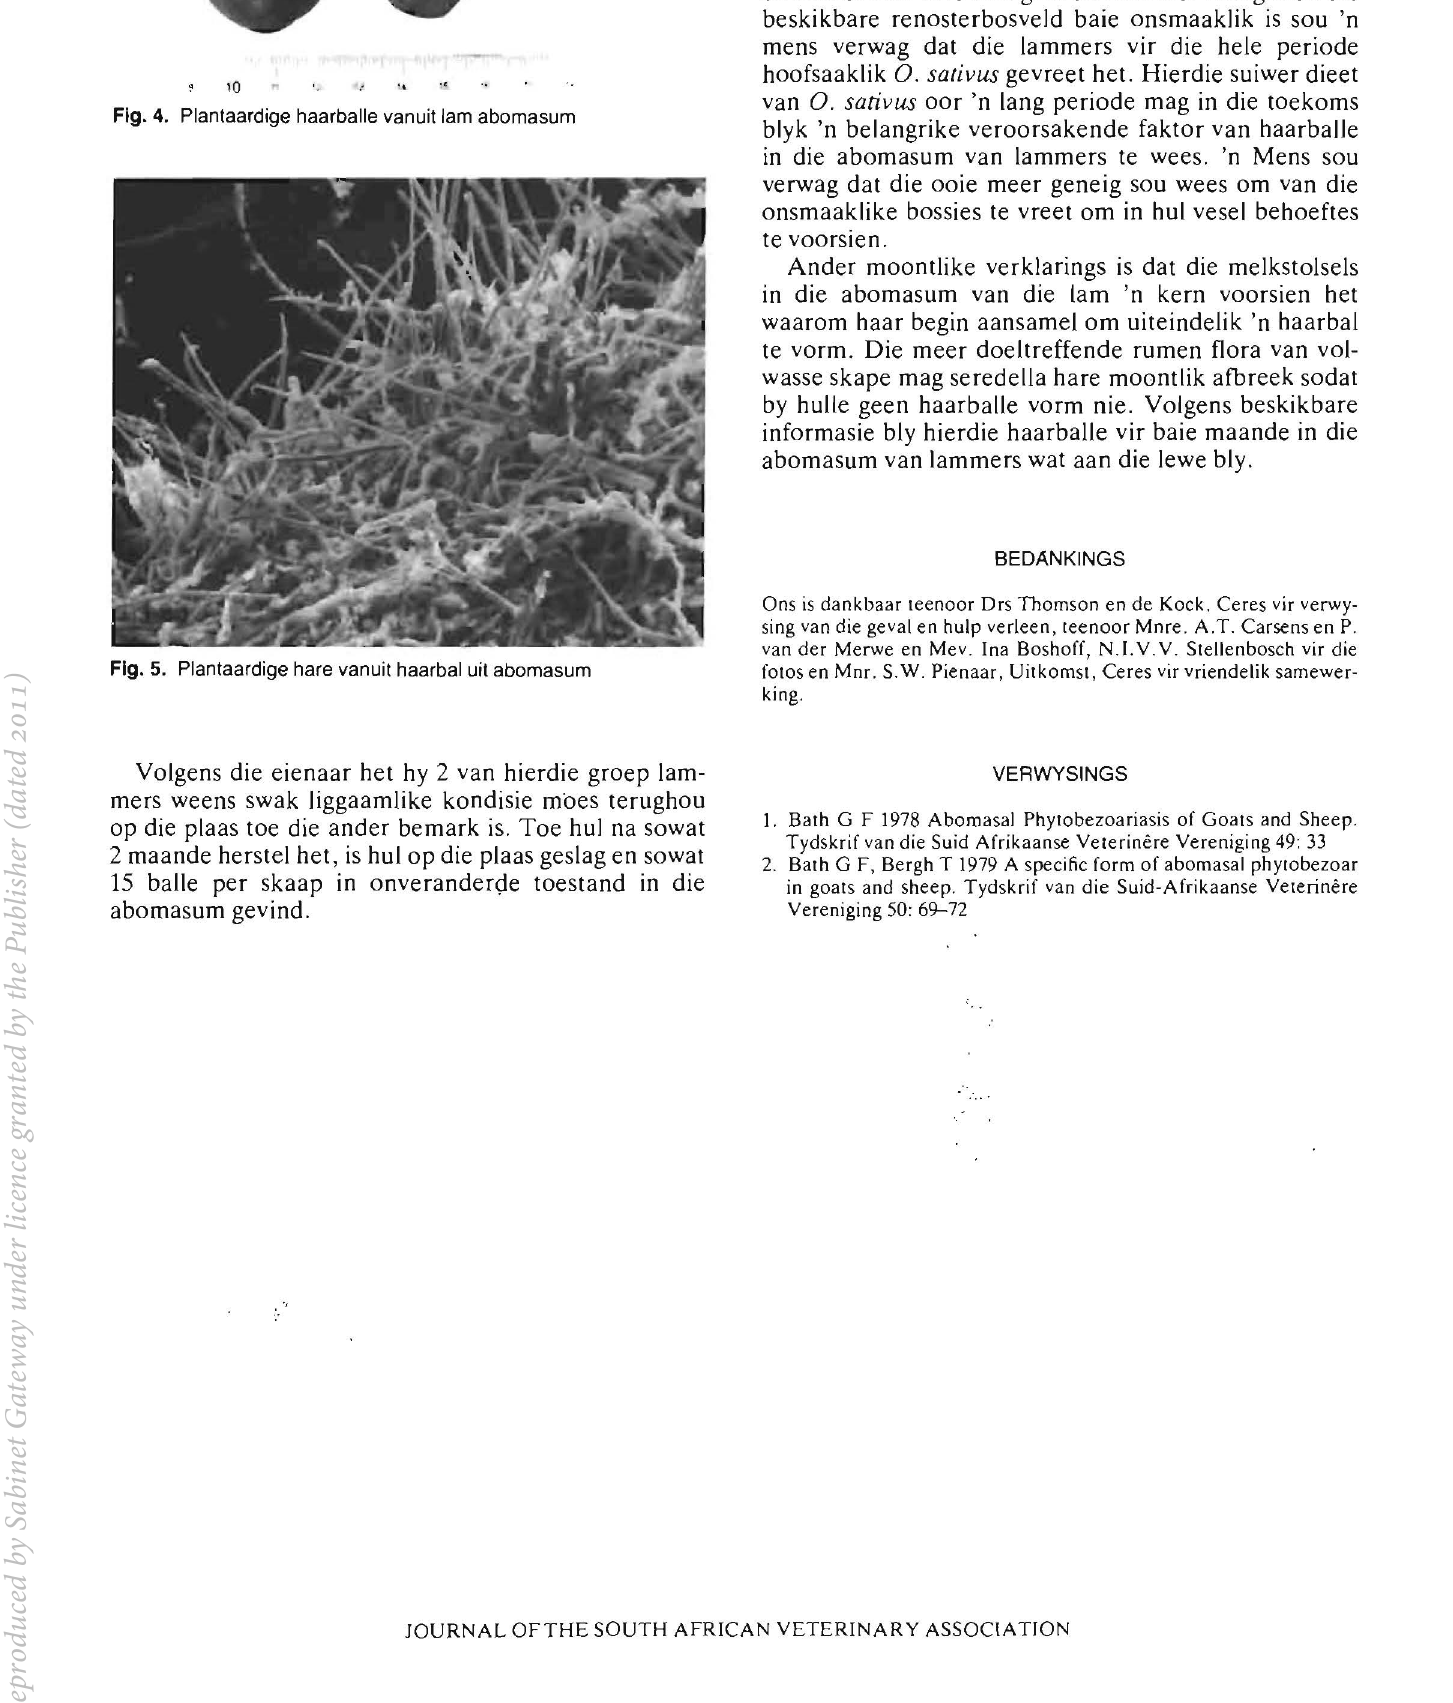
Fig. 5. Plantaardige hare vanuit haarbal uit abomasum